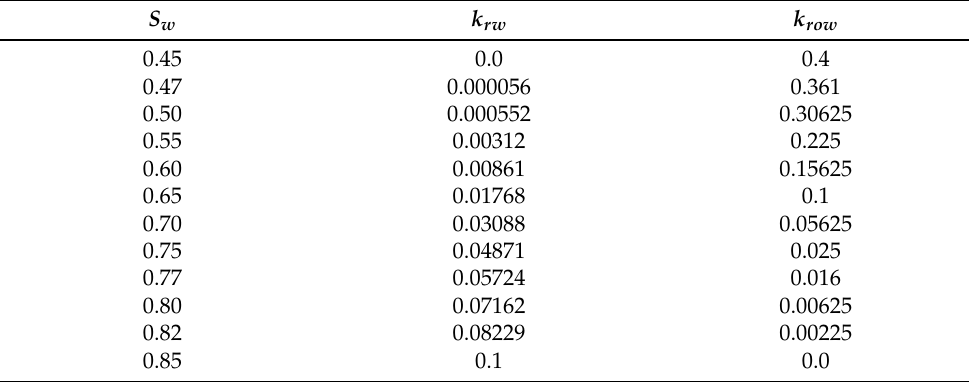
Table 1. Oil–water relative permeability for Example 1.